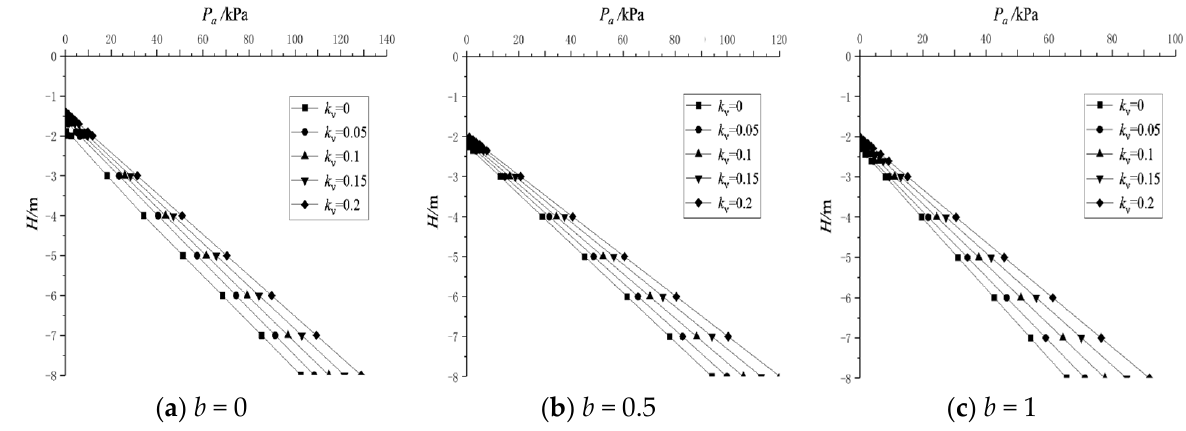
Figure 5. Intensity distribution of Rankine active earth pressure ( k h = 0.1).